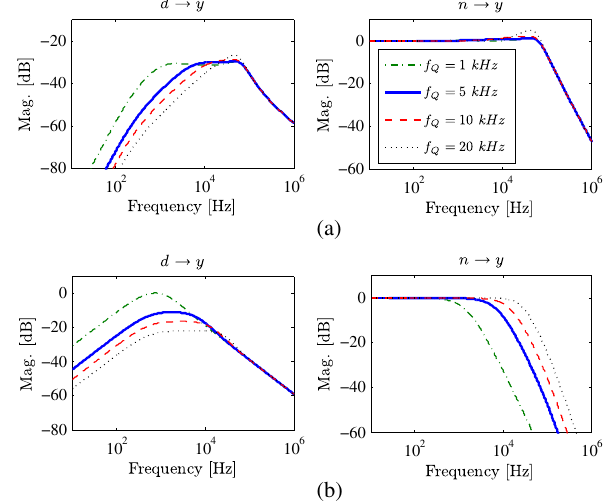
FIG. 13. Transfer functions from d and n to y via different Q filter bandwidths (assuming δω ¼ 0 and δθ ¼ 0 ). (a) PI þ DOB control and (b) FF þ DOB